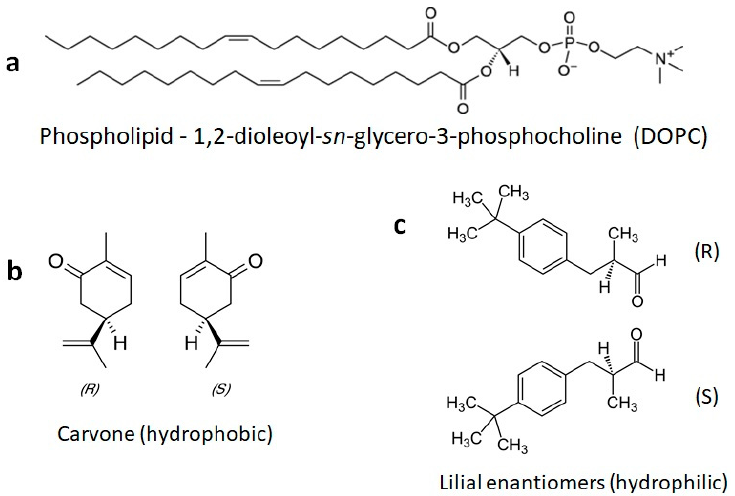
Figure 1. Chemical structures of a phospholipid and the odorants used here. ( a ) The phospholipid DOPC is commonly used to form fluid model membranes in water at room temperature. ( b ) The odorants S-carvone and R-carvone. ( c ) The odorant lilial, which was used here as a racemic mixture.